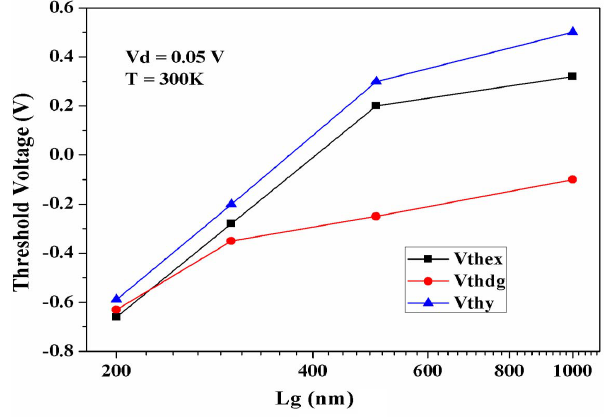
Figure 5. Threshold voltages (V th ) vs L g comparison extracted by different